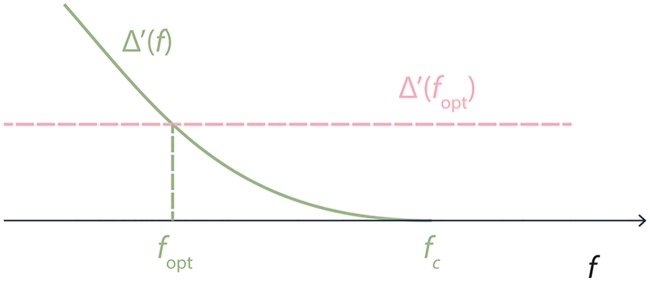
Schematic representation of Δ′(f). The value Δ′(fopt) is given by Eq (6).